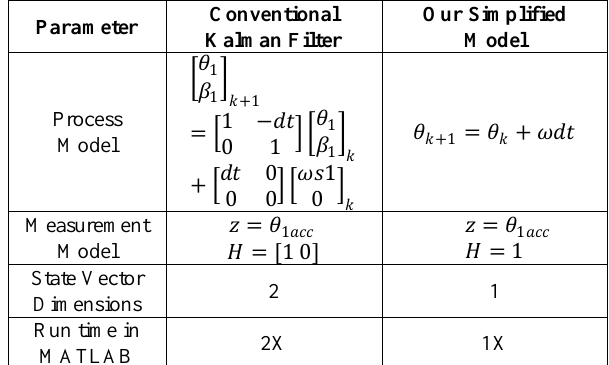
Table 1 Comparison of Conventional and Simplified KF models